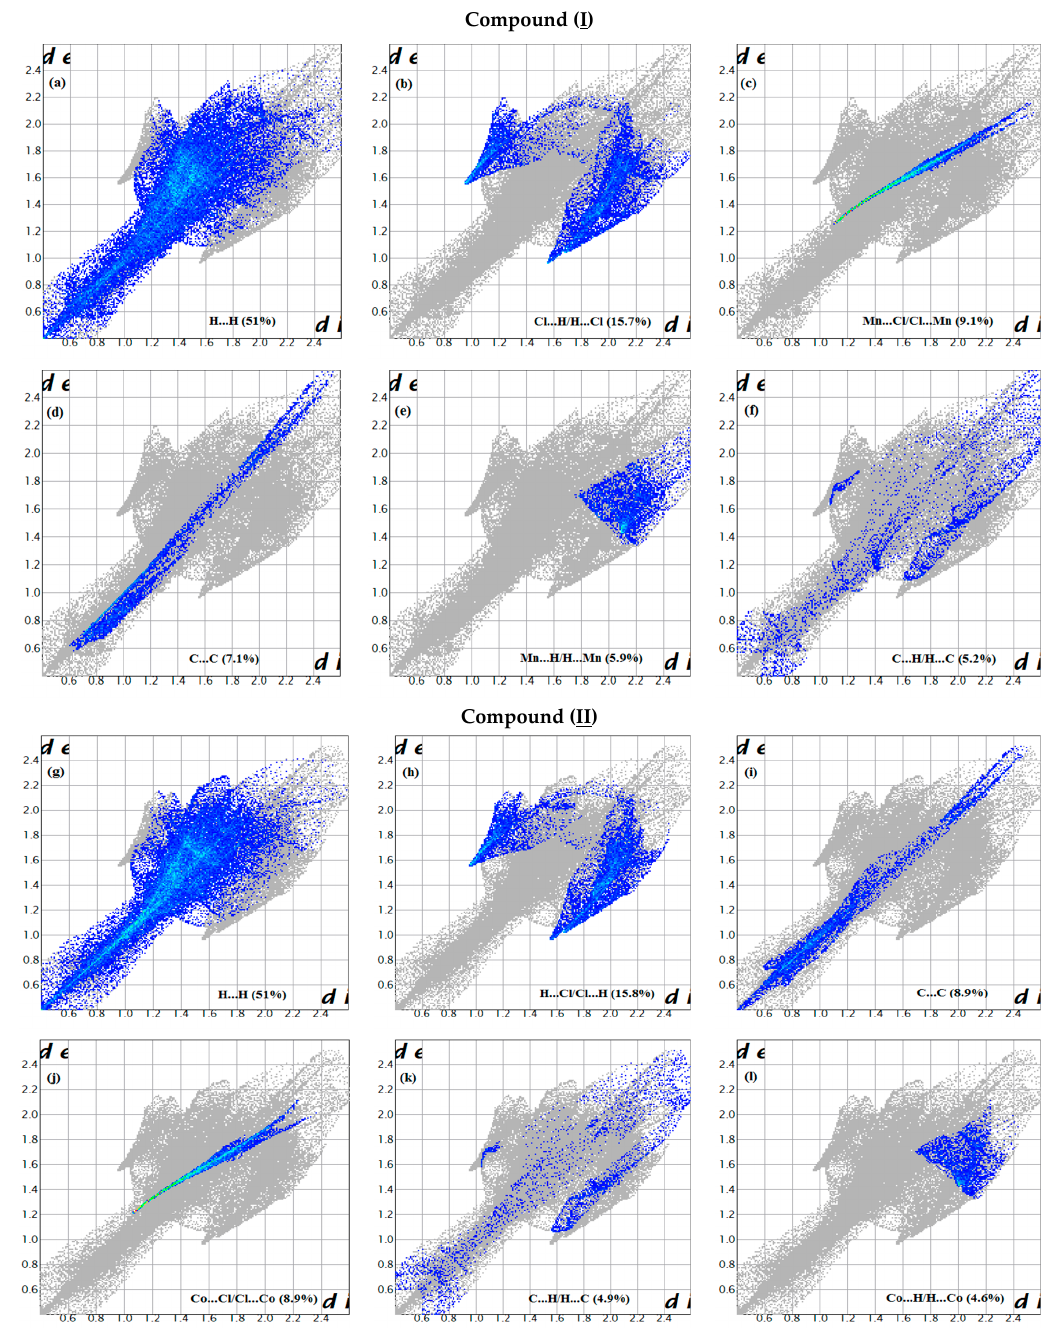
Figure 7. The 2D fingerprint maps of compounds ( I ) and ( II ): ( a ) H . . . H contacts for compound( I ); ( b ) H . . . Cl/H . . . Cl contacts of compound ( I ); ( c ) Mn . . . Cl/Cl . . . Mn contacts of compound ( I ); ( d ) C . . . C contacts of compound ( I ); ( e ) Mn . . . H/H . . . Mn contacts of compound ( I ); ( f ) C . . . H/H . . . C contacts of compound ( I ); ( g ) H . . . H contacts of compound ( II ); ( h ) H . . . Cl/H . . . Cl contacts of compound ( II ); ( i ) C . . . C contacts of compound ( II ); ( j ) Co . . . Cl/Cl . . . Co contacts of compound ( II ); ( k ) C . . . H/H . . . C contacts of compound ( II ); ( l ) Co . . . Cl/Cl . . . Co contacts of compound ( II